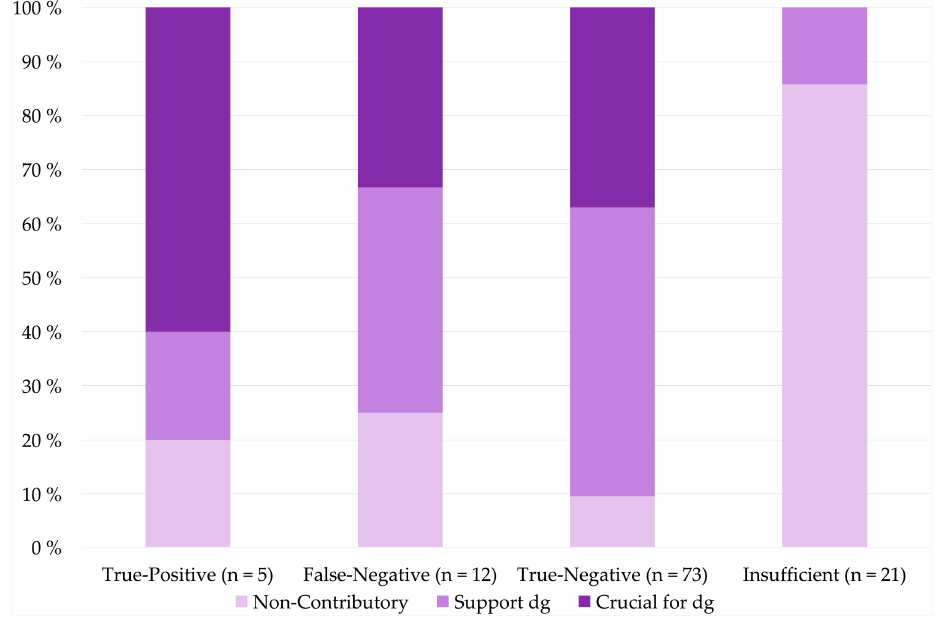
Figure 4. Cell block contribution by cyto-histological correlation.